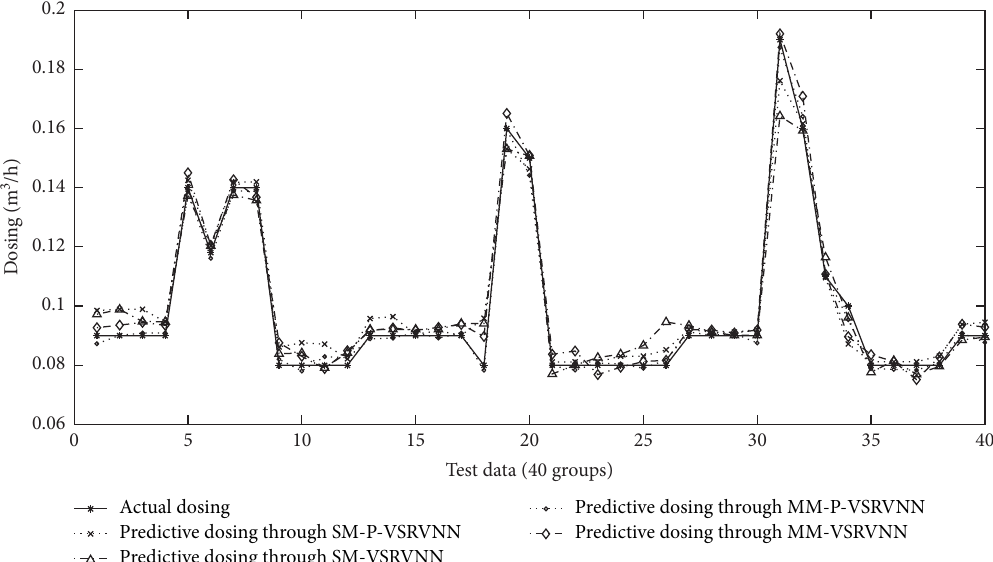
Figure 8: Prediction output for dosing with four different algorithms.